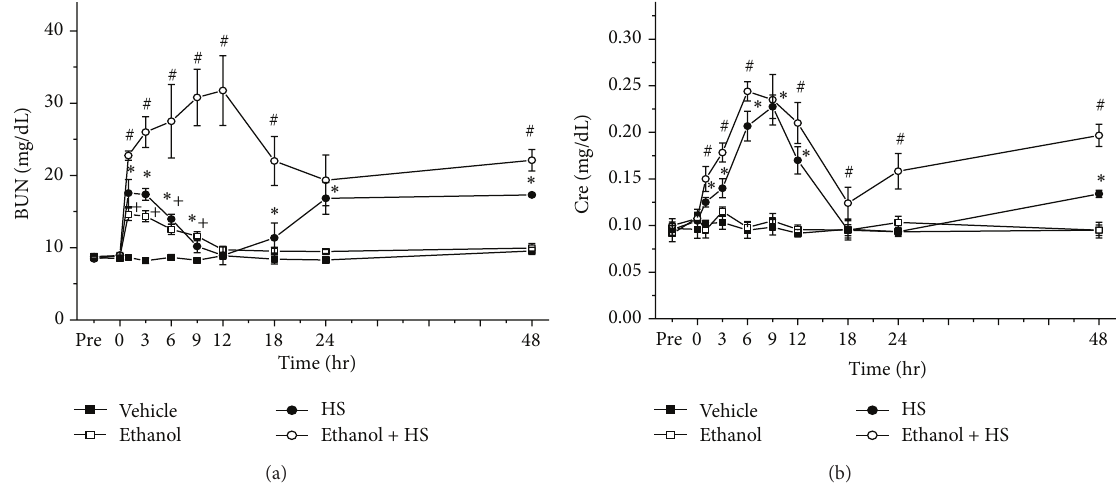
Figure 4: Changes in serum (a) blood urea nitrogen (BUN) and (b) creatinine (Cre) after hemorrhagic shock in rats. ∗ 𝑃 < 0.05 for the HS group compared with the Vehicle group. + 𝑃 < 0.05 for the Ethanol group compared with the Vehicle group. # 𝑃 < 0.05 for the Ethanol + HS group compared with the HS